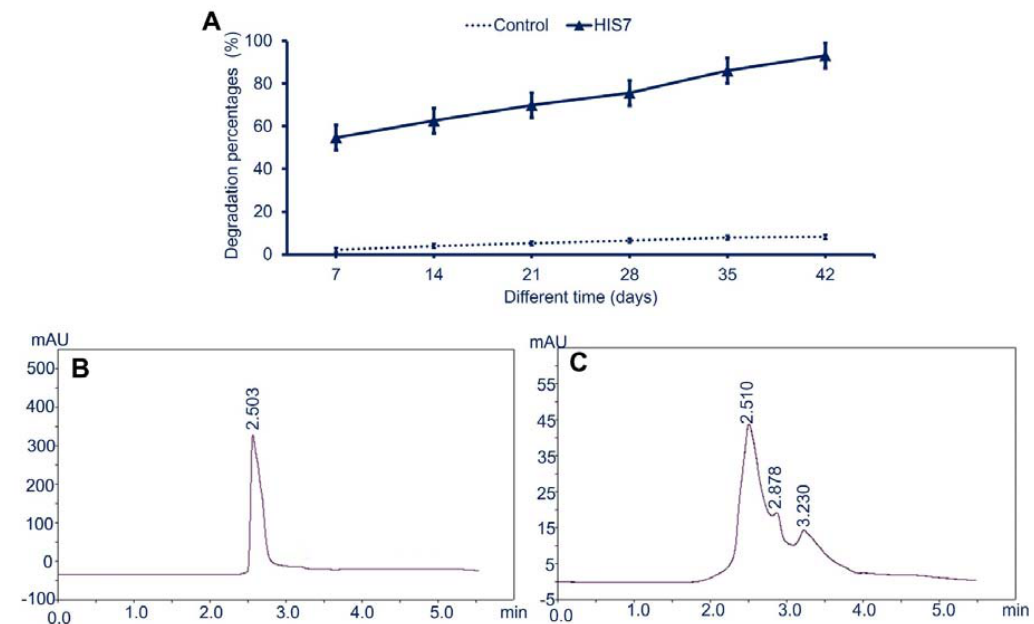
Figure 6. The biodegradation assay of cypermethrin in soil inoculated by bacterial strain HIS7. Panel ( A ) is a qualitative assay of cypermethrin in soil over time using the spectrophotometric method; panels ( B , C ) are the HPLC chart of soil cypermethrin in the absence and presence of bacterial inoculation, respectively. Data in panel ( A ) represented by Mean ± SE (n =